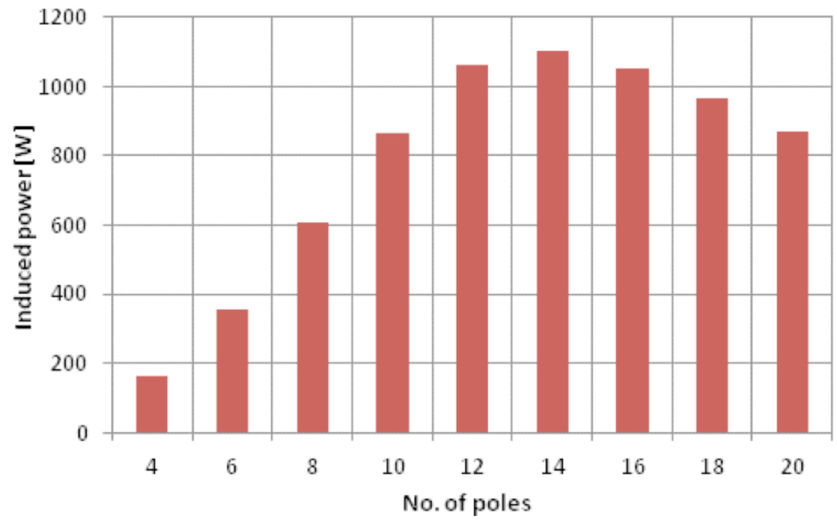
Fig. 4. In fl uence of number of poles on the induced power of